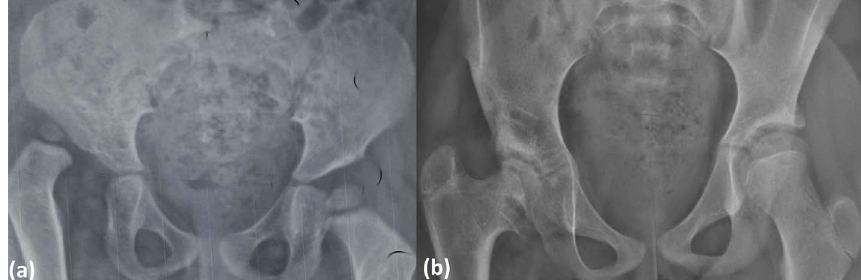
Figure 3. (a) Preoperative radiograph of a girl 2.5 years old of age with right DDH; (b) radiograph at the age of 11 (8.5 years follow-up after